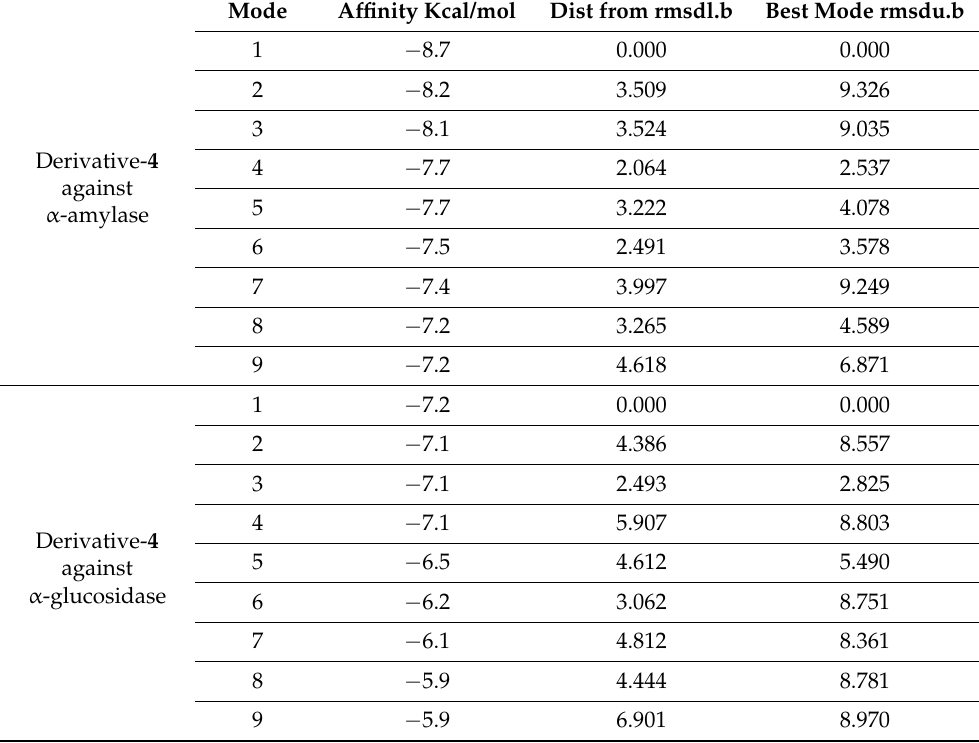
Table 2. The binding affinity and RMSD value of derivative 4 against α -amylase and α -glucosidase.